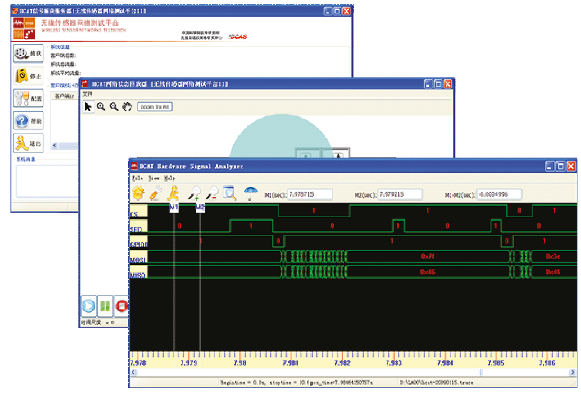
Figure 14: Screenshots of test server applications.